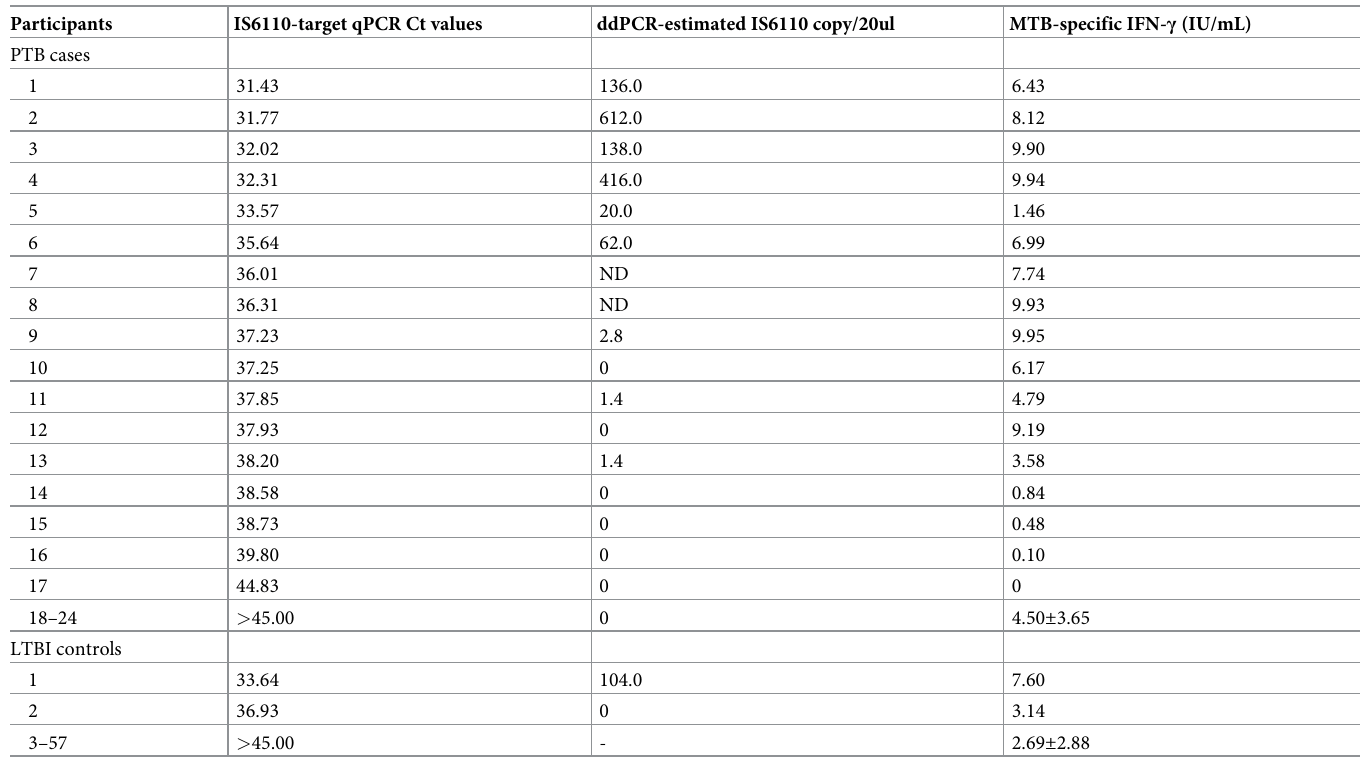
Table 2. Results of IS6110 -targeted PCR ( n =